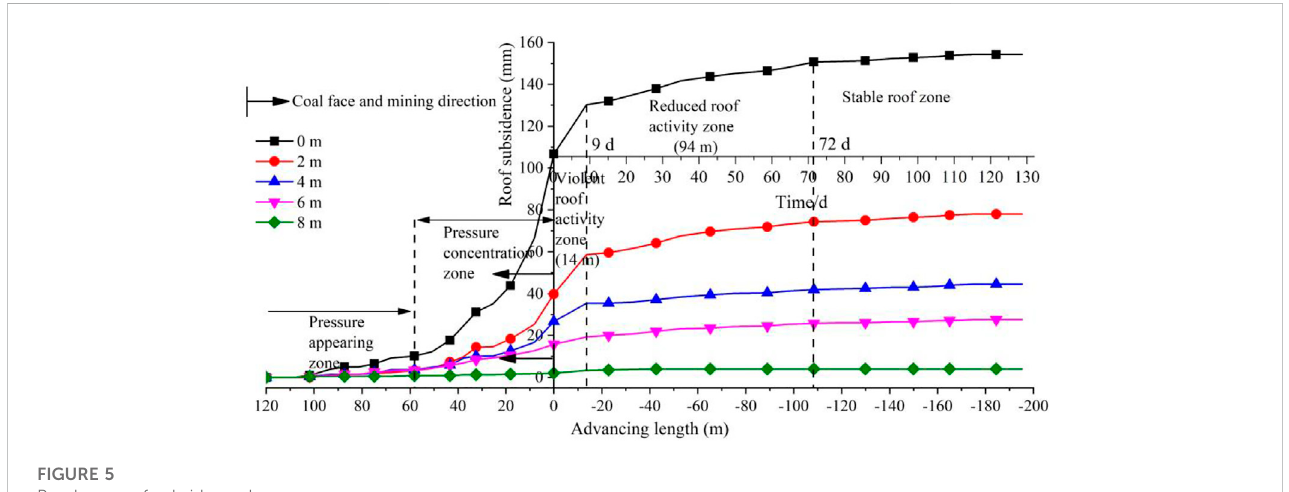
FIGURE 5 Roadway roof subsidence law.